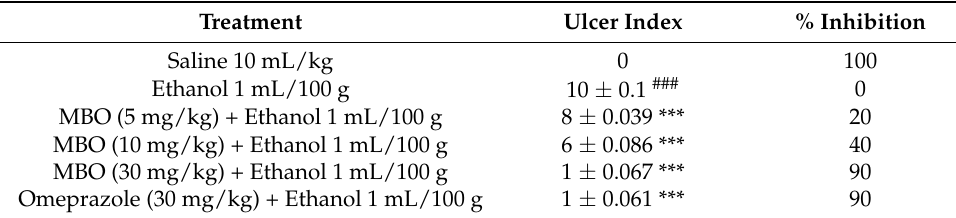
Table 4. Protective effect of MBO and omeprazole against ethanol (1 mL/100g)-induced gastric ulcer model in